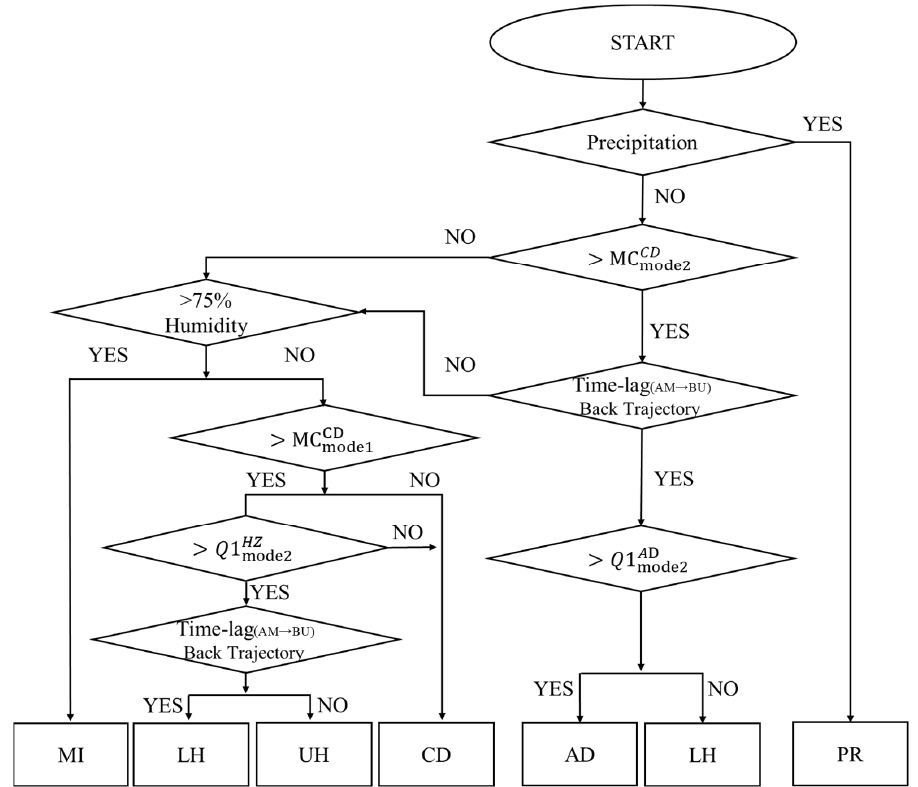
Figure 2. Classification of urban haze (UH), long ‐ range transported haze (LH), Asian dust (AD), mist (MI), precipitation (PR), and clear days (CD). MC stands for the aerosol mass concentration; Mode 1 is the fine aerosol channel (0.5–1.0 μ m); Mode 2 is the coarse aerosol channel (3–5 μ m); AM and BU refer to Anmyeondo and Busan sites, respectively; and Q1 indicates the 25th percentile concentration.